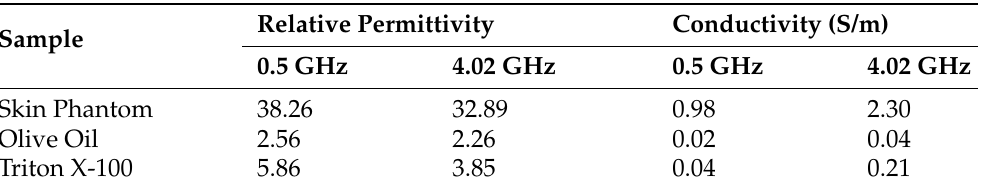
Table 1. Relative permittivity and conductivity measurements of each layer in double-layered configurations at 0.5 GHz and 4 GHz.